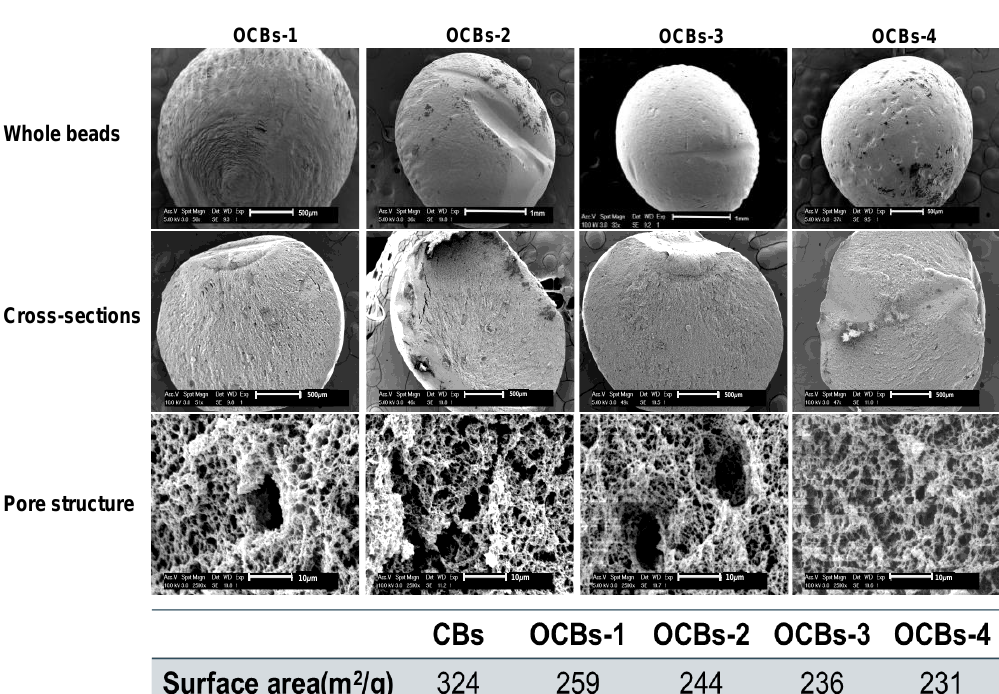
Figure 3. SEM images and surface area of OCBs-1 to OCBs-4. Each row from top to bottom is the morphology of whole beads, cross-section, and porous structure inside, with magnifications 50×, 50×, and 2500×, respectively.